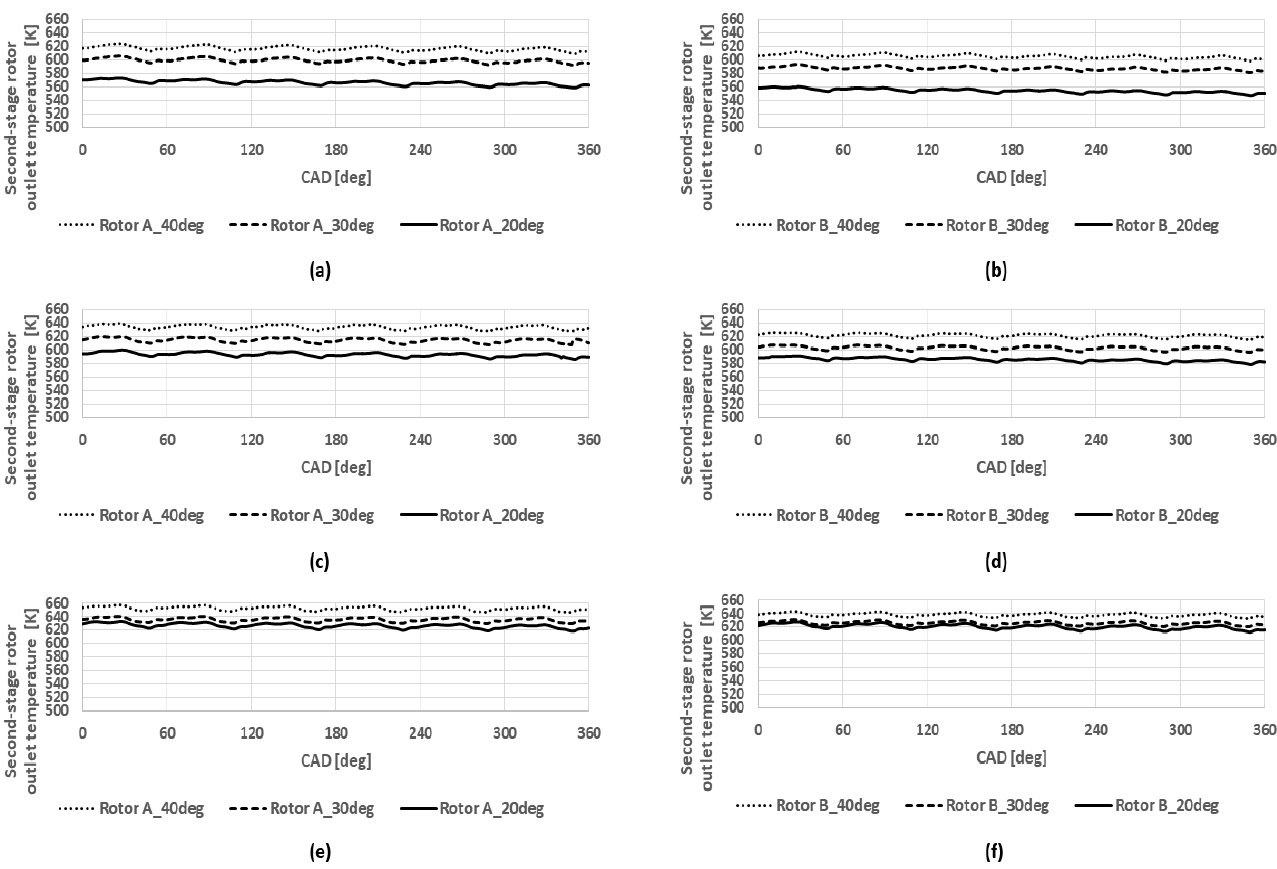
shown in Figure 26.